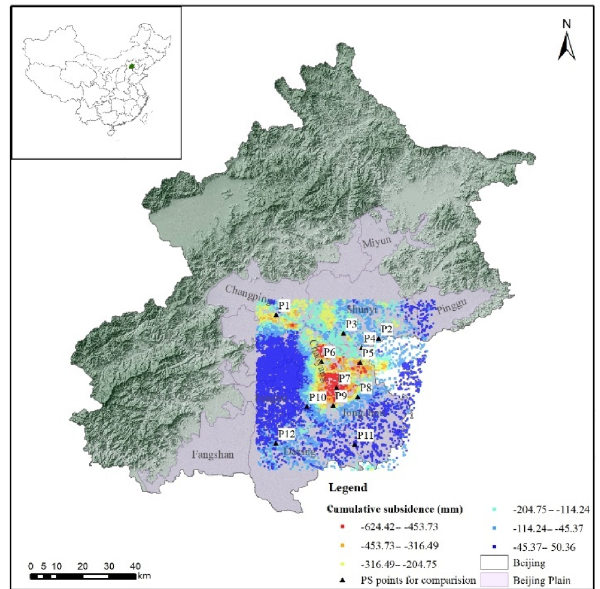
Figure 1. The location of the study area and land subsidence from 2011 to 2015 derived from RadarSat-2 images (the digital elevation model data are from the Shuttle Radar Topography Mission – SRTM – website).